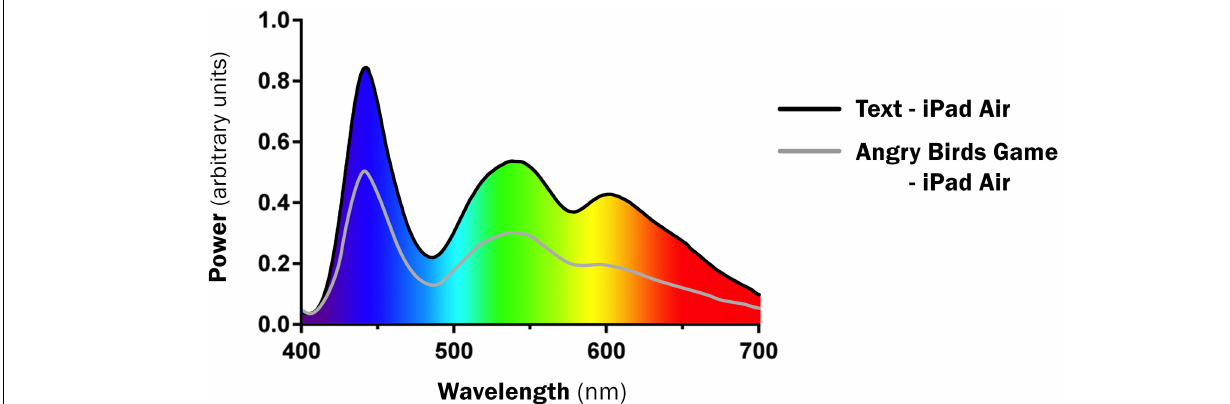
FIGURE 2 | Spectral Profile of Text compared to game (same device).